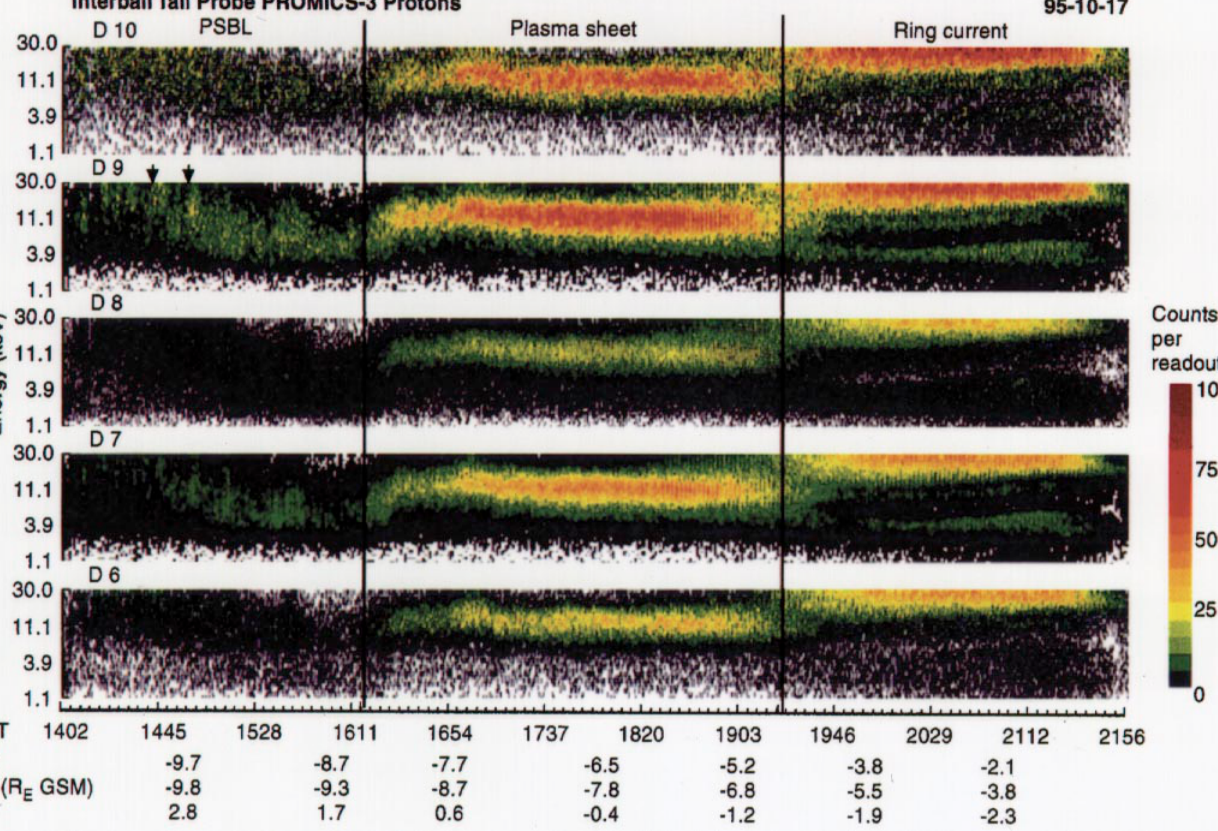
Fig. 10. Spectrogram obtained during a traversal of the magnetotail on 17 October 1995. The intensity scale is counts per readout, which is approximately proportional to the energy flux. The accumulation